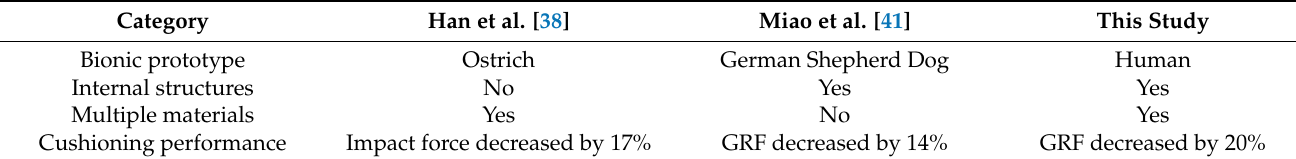
Table 4. Comparison of different bionic